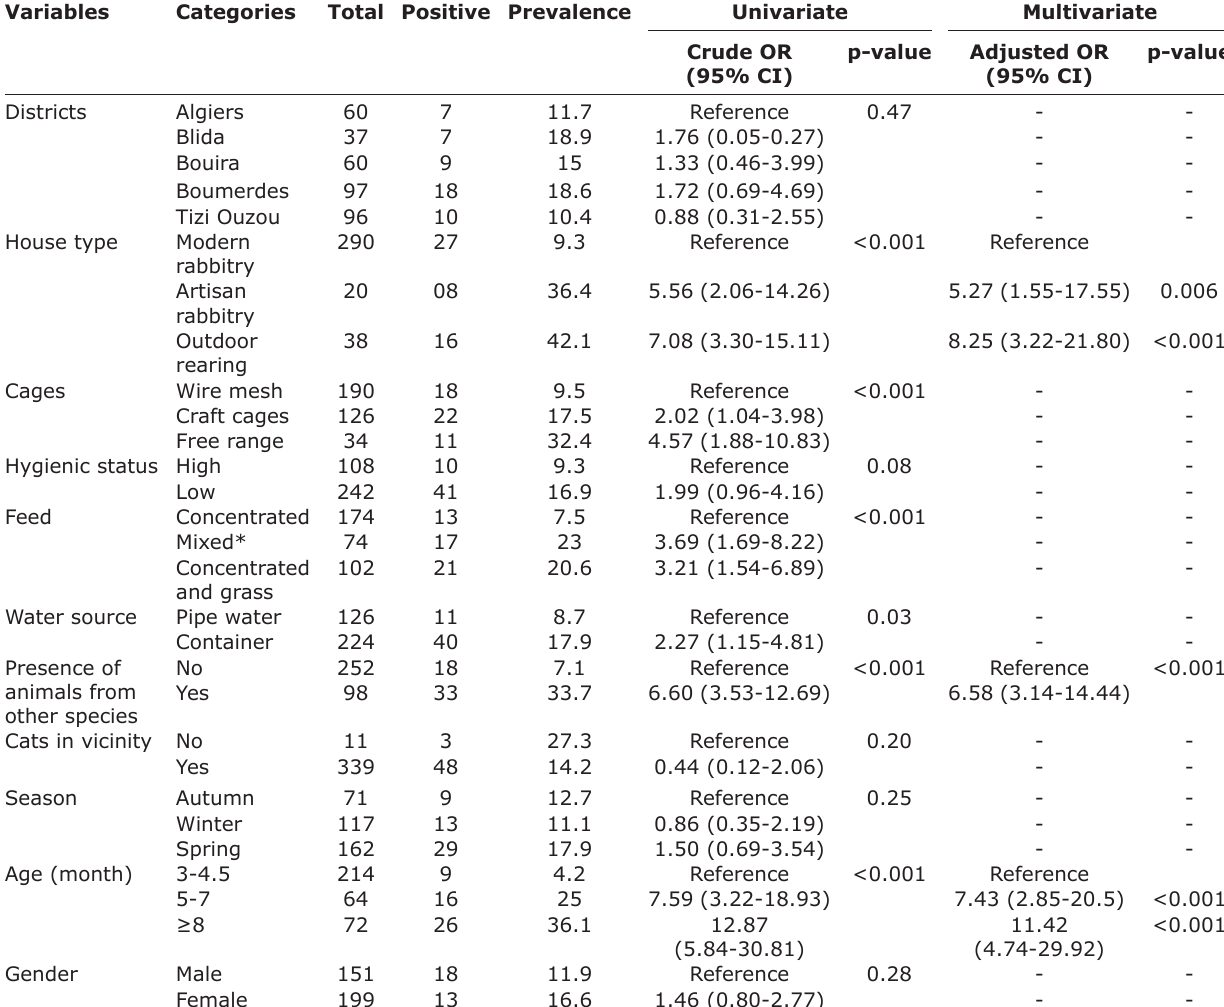
Table-1: Seroprevalence of Toxoplasma gondii in rabbits of local Algerian population and associated factors risk in different districts of Northern Algeria.